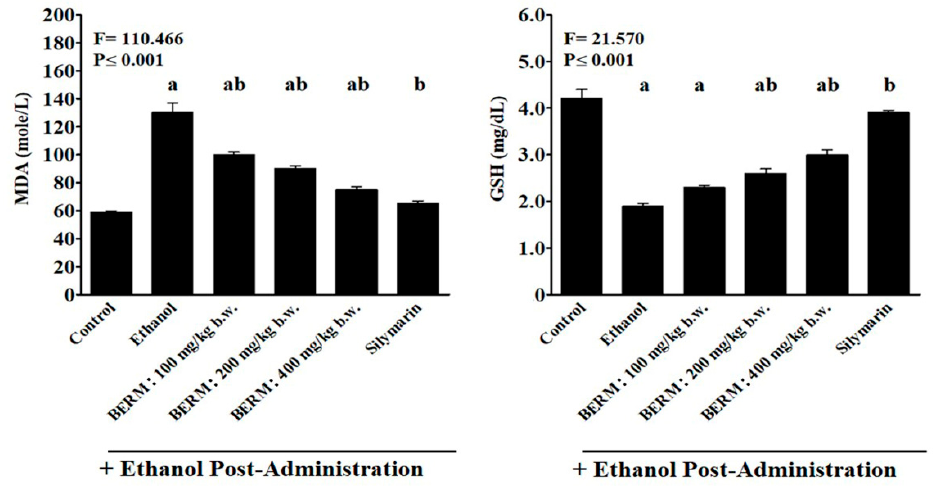
Figure 4. Effect of BERM pre-administration on hepatic tissue GSH and MDA levels following to ethanol-induced liver damage. The bar graphs show hepatic tissue levels of GSH and MDA measured using colorimetric methods involving specific substrates such as 5-5’-dithio-bis(2-nitrobenzoic acid) (DNTB) and 2-thiobarbituric acid (TBA) solutions, respectively. Refer to the methods section for more information. The letters a, b and ab, clearly indicate that they are statistically significant with the control (untreated) mouse group, with the ethanol group, and with the control and ethanol groups, respectively. The results are presented as the mean ± SEM based on five independent experiments.